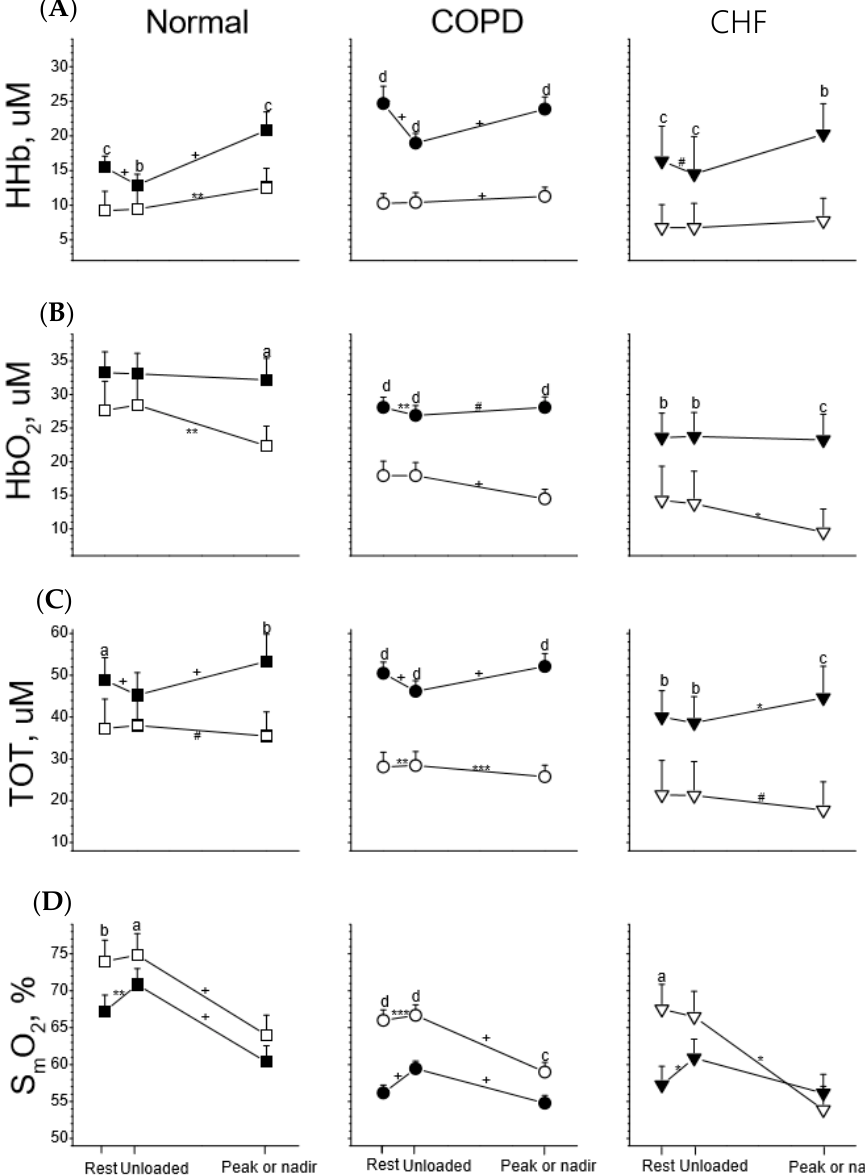
Figure 2. Tissue deoxygenation (HHb, row ( A )), oxygenation (HbO 2 , row ( B )), total blood capacity (TOT, row ( C )), and saturation (S m O 2 , row ( D )) of leg muscles (solid symbol) and ventilatory muscles (open symbol) in response to incremental exercise in healthy subjects (Normal) and subjects with chronic obstructive pulmonary disease (COPD) and congestive heart failure (CHF). Paired t tests were used for comparison between two muscles at three stages of the exercise test, respectively: a p < 0.05, b p < 0.01, c p < 0.001, d p < 0.0001; paired t tests were used for comparisons of changes in variables between rest and unloaded exercise and between unloaded exercise and at peak (or nadir) exercise, respectively: # p < 0.1, * p < 0.05, ** p < 0.01, *** p < 0.001, + p <